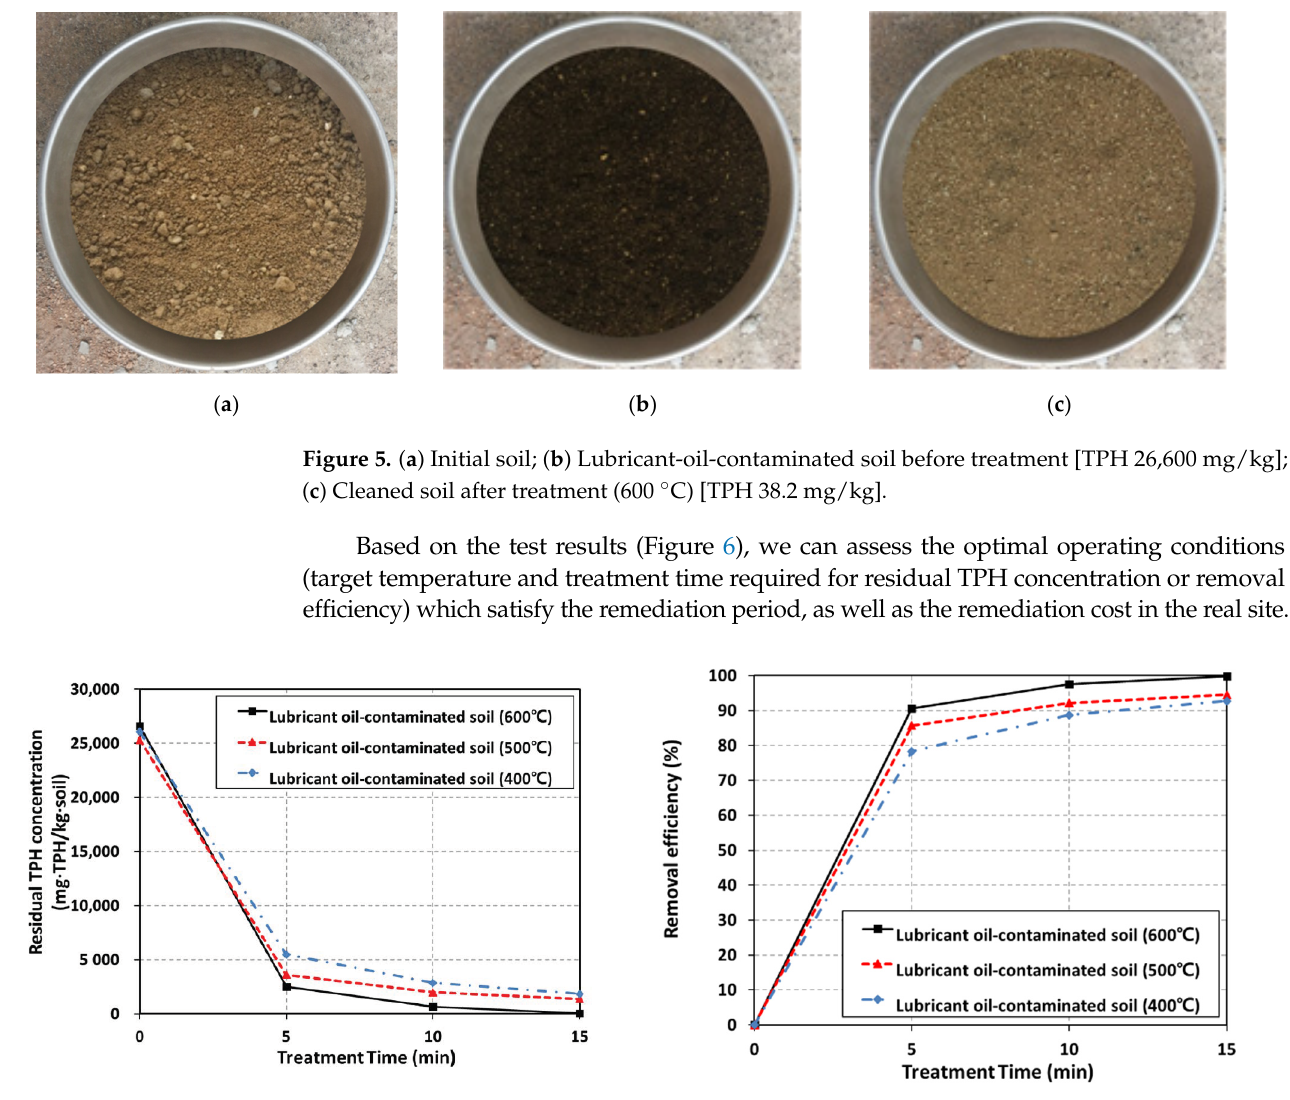
Figure 6. Remediation results: ( a ) Residual TPH concentration and ( b ) Removal efficiency.